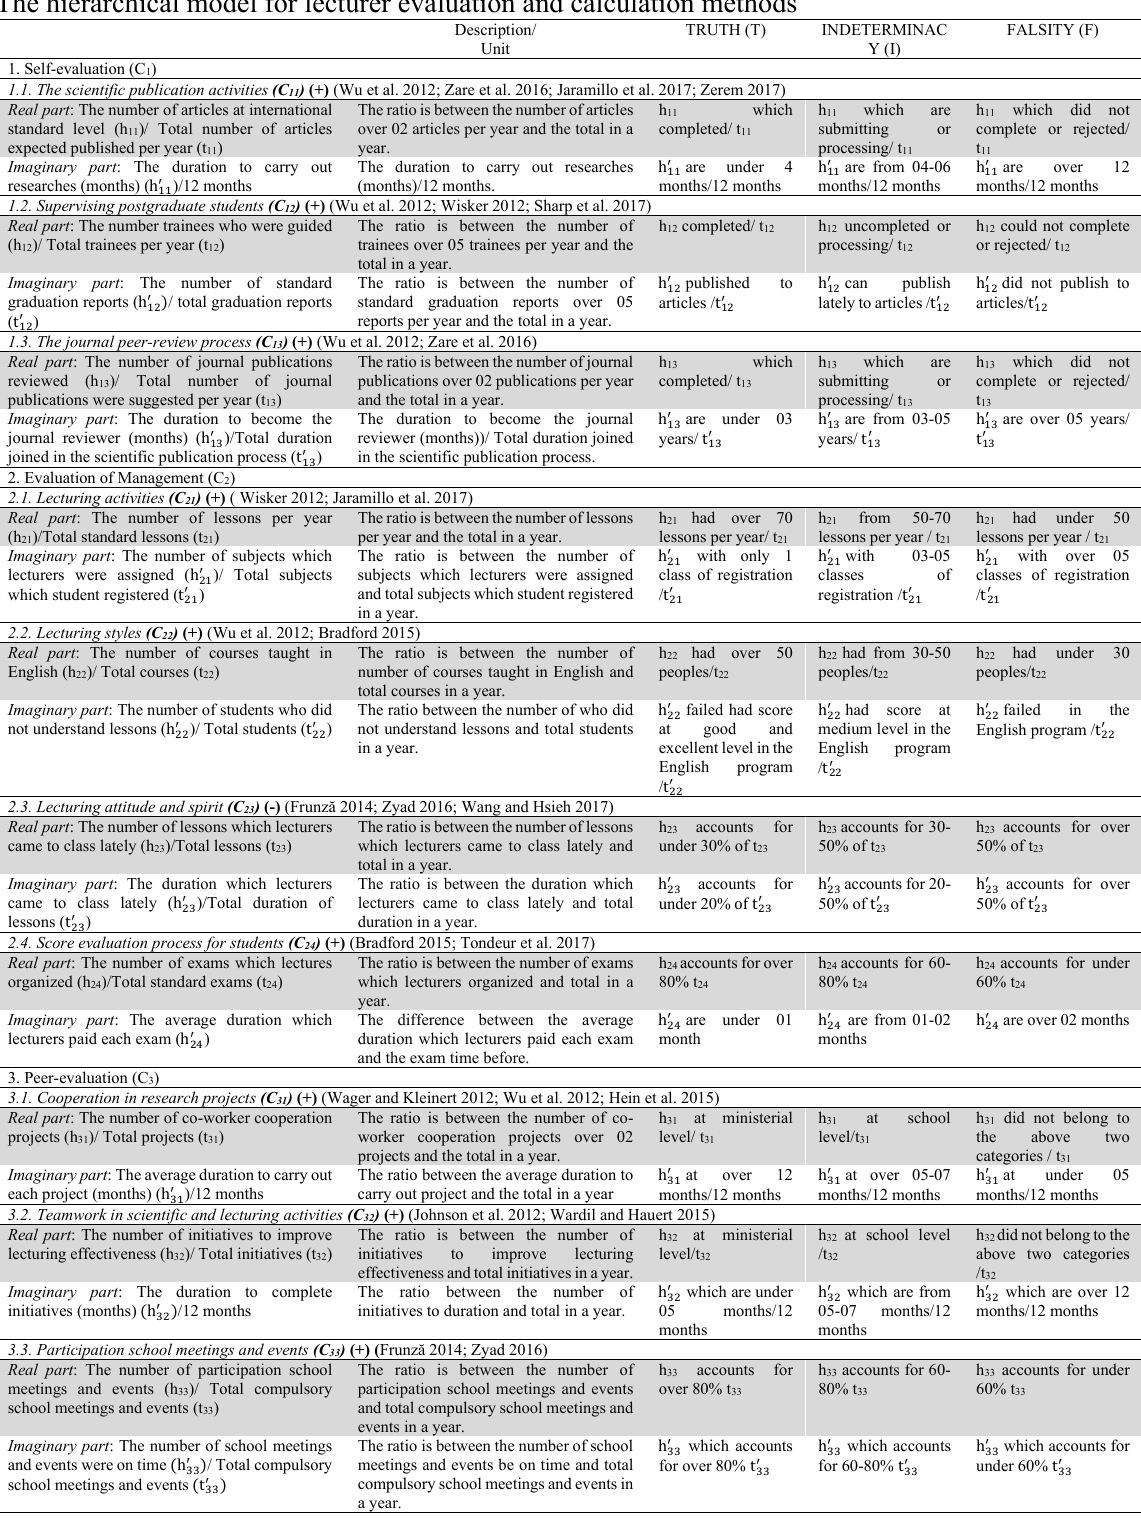
Table 1 The hierarchical model for lecturer evaluation and calculation methods